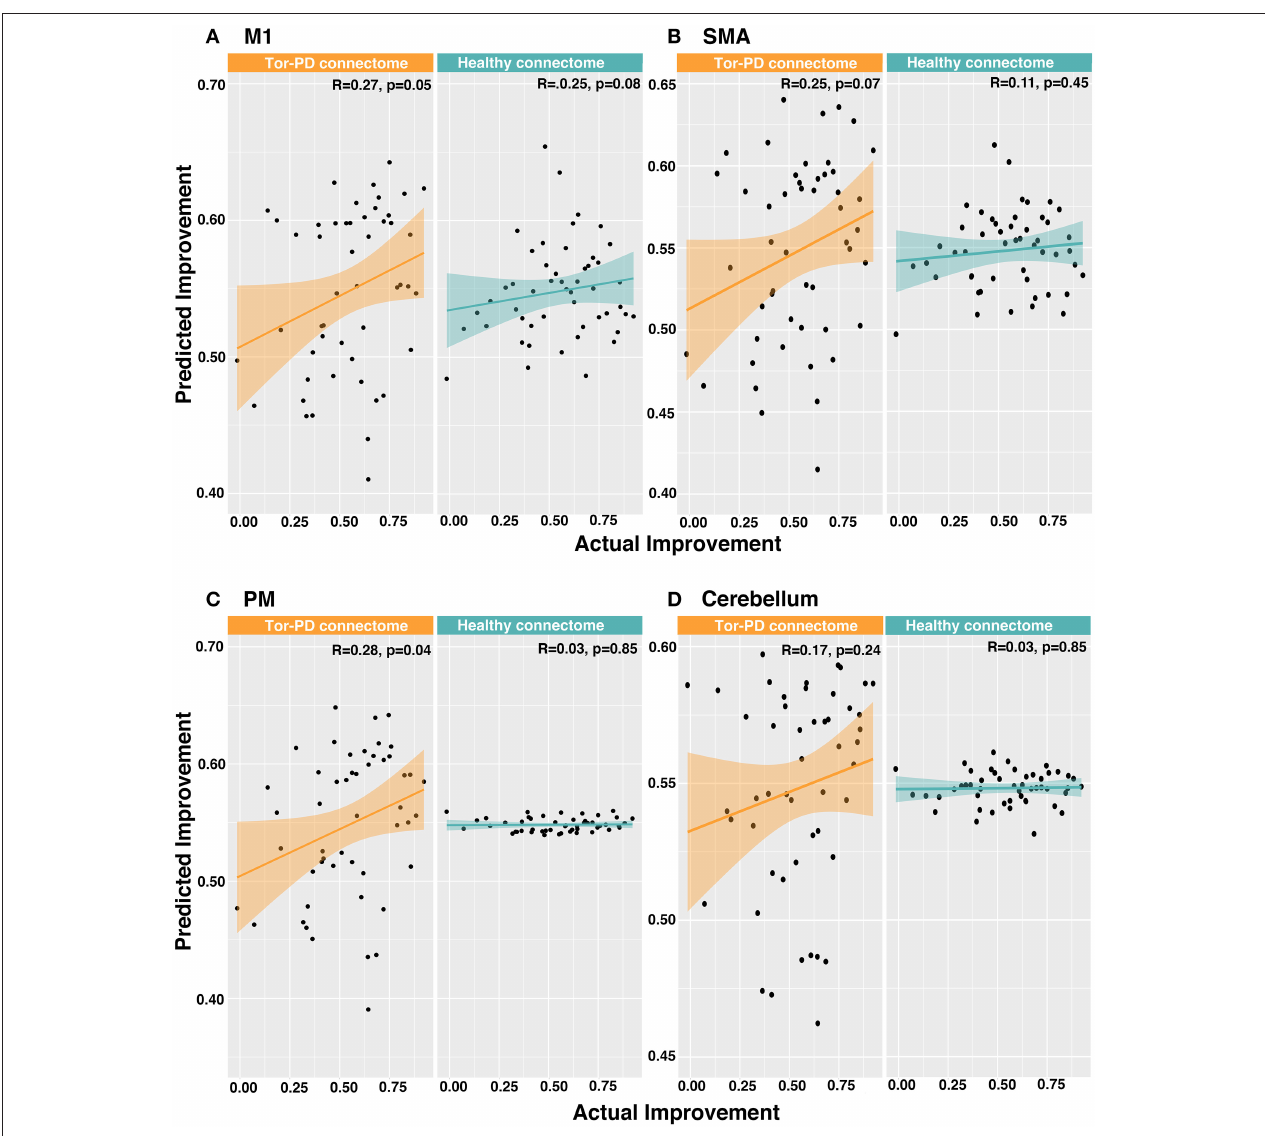
FIGURE 4 | Predicting DBS outcome in PD patients based on functional connectivity of VTAs to motor ROIs. Actual vs. predicted improvement based on functional connectivity of VTAs to M1 (A) , SMA (B) , PM (C) , and cerebellum (D) . DBS, deep brain stimulation; M1, primary motor cortex; SMA, supplementary motor area; PD, Parkinson’s disease; PM, premotor cortex; VTAs, volumes of tissue